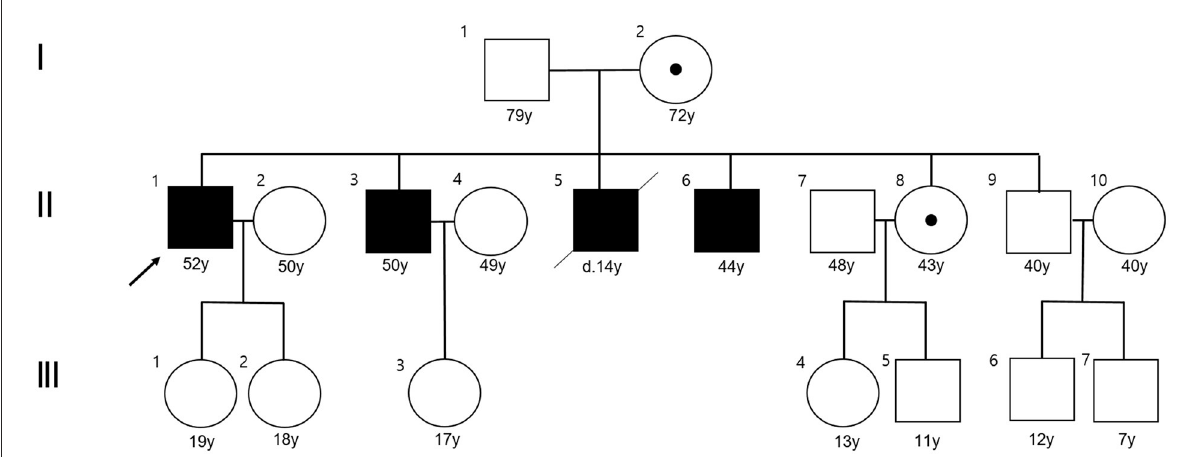
FIGURE1 Pedigree of the present family. The proband is indicated by an arrow. Affected males are designated by filled symbols and the carrier female by circle with dot (squares for males and circles for females).